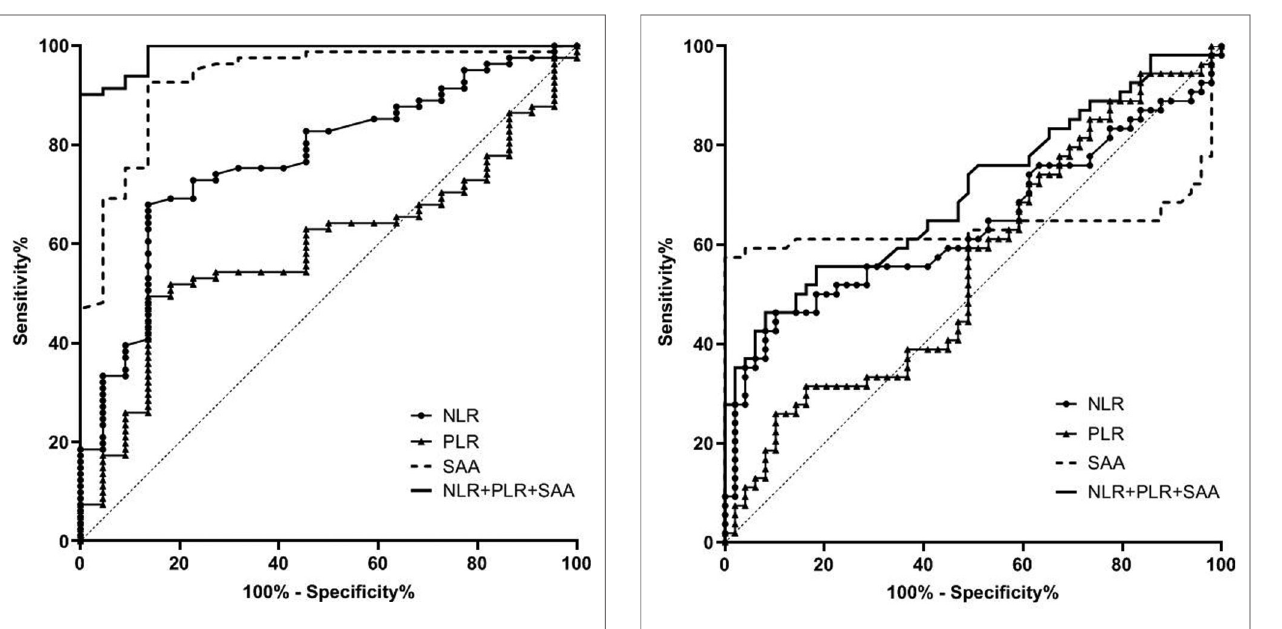
FIGURE 2 | Value of serum NLR, PLR and SAA levels in predicting patients with stage I-II CRC.